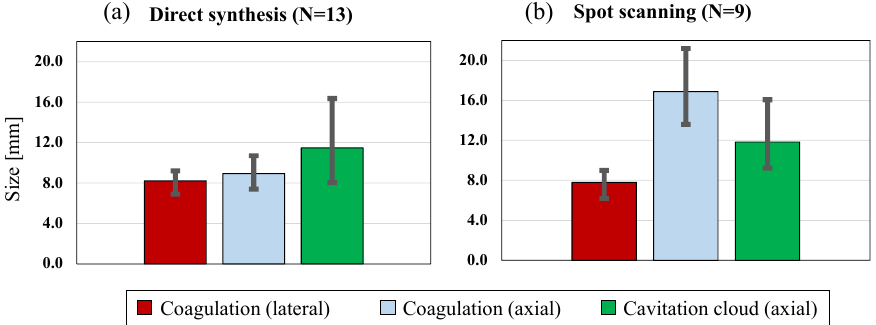
Figure 14. Ultrasonically detected cloud size and the coagulation area size [35]. ( a ) spot scanning; ( b ) direct synthesis.